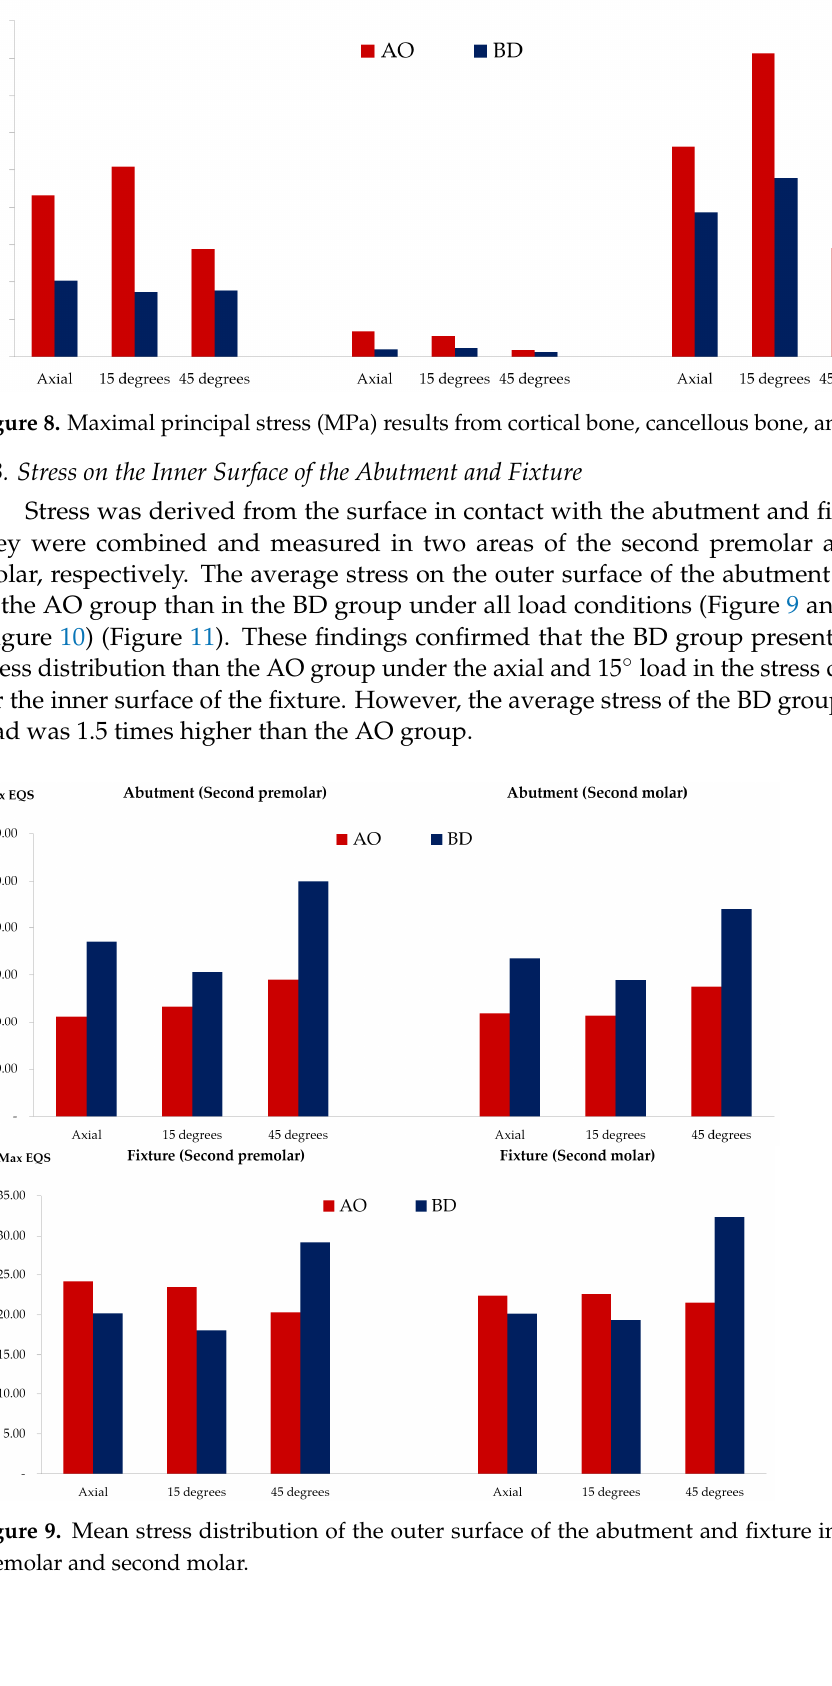
Figure 10. Stress distribution diagram of the abutment in both models.